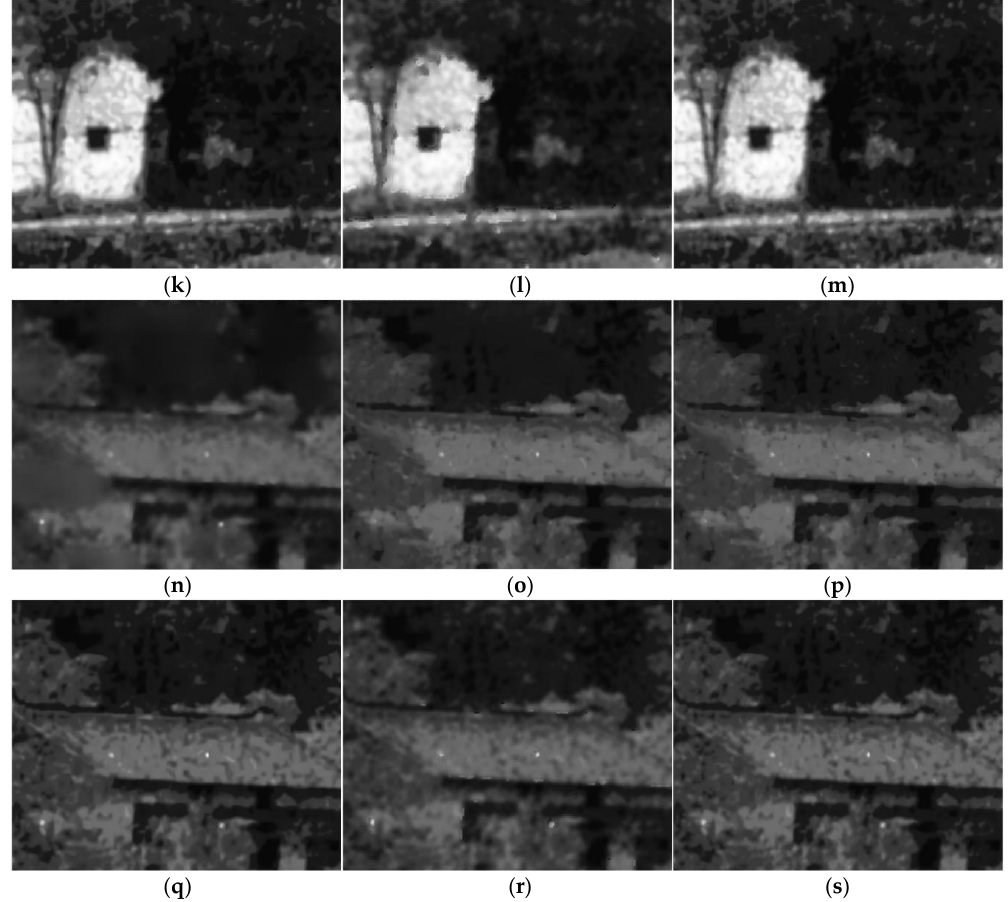
Figure 6. The subjective results of the proposed algorithm and other baselines. ( a ) the patches in the noisy ICCD image; ( b , h , n ) the result of the denoising algorithm in [2]; ( c , i , o ) the result of the proposed algorithm; ( d , j , p ) the result without the RPCA in Section 4.5; ( e , k , q ) the results of BM3D; ( f , l , r ) the result of K-SVD; ( g , m , s ) the results of BLS-GSM.